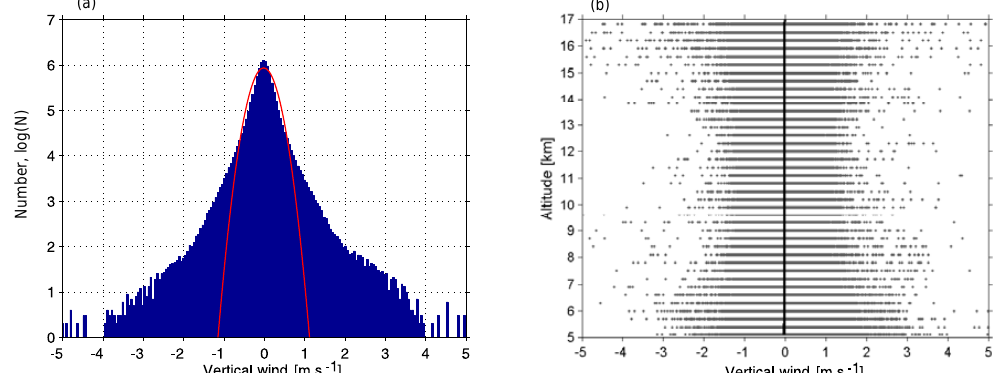
Figure 4. (a) Histogram of number densities of vertical wind velocity in logarithmic scales with the fitting line by a Gaussian function indicated in red; (b) scatter plot of vertical wind velocities along the altitudes with the mean profile indicated with a black solid